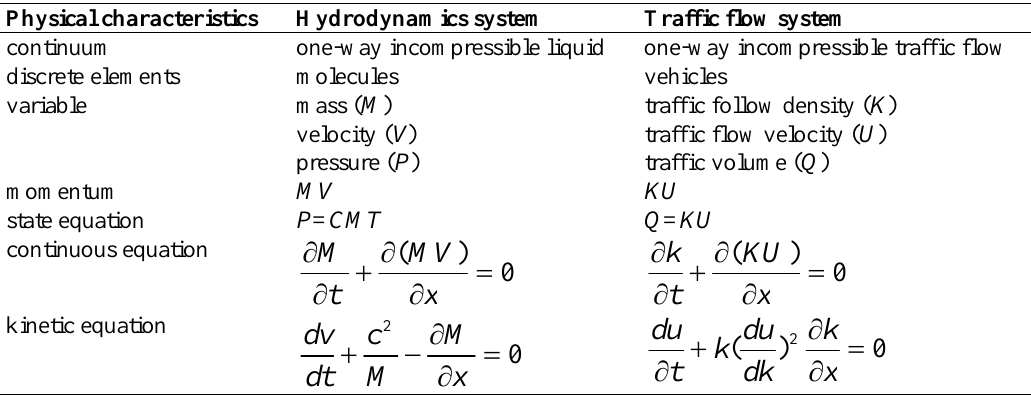
Table 1. Similarities between traffic flow and